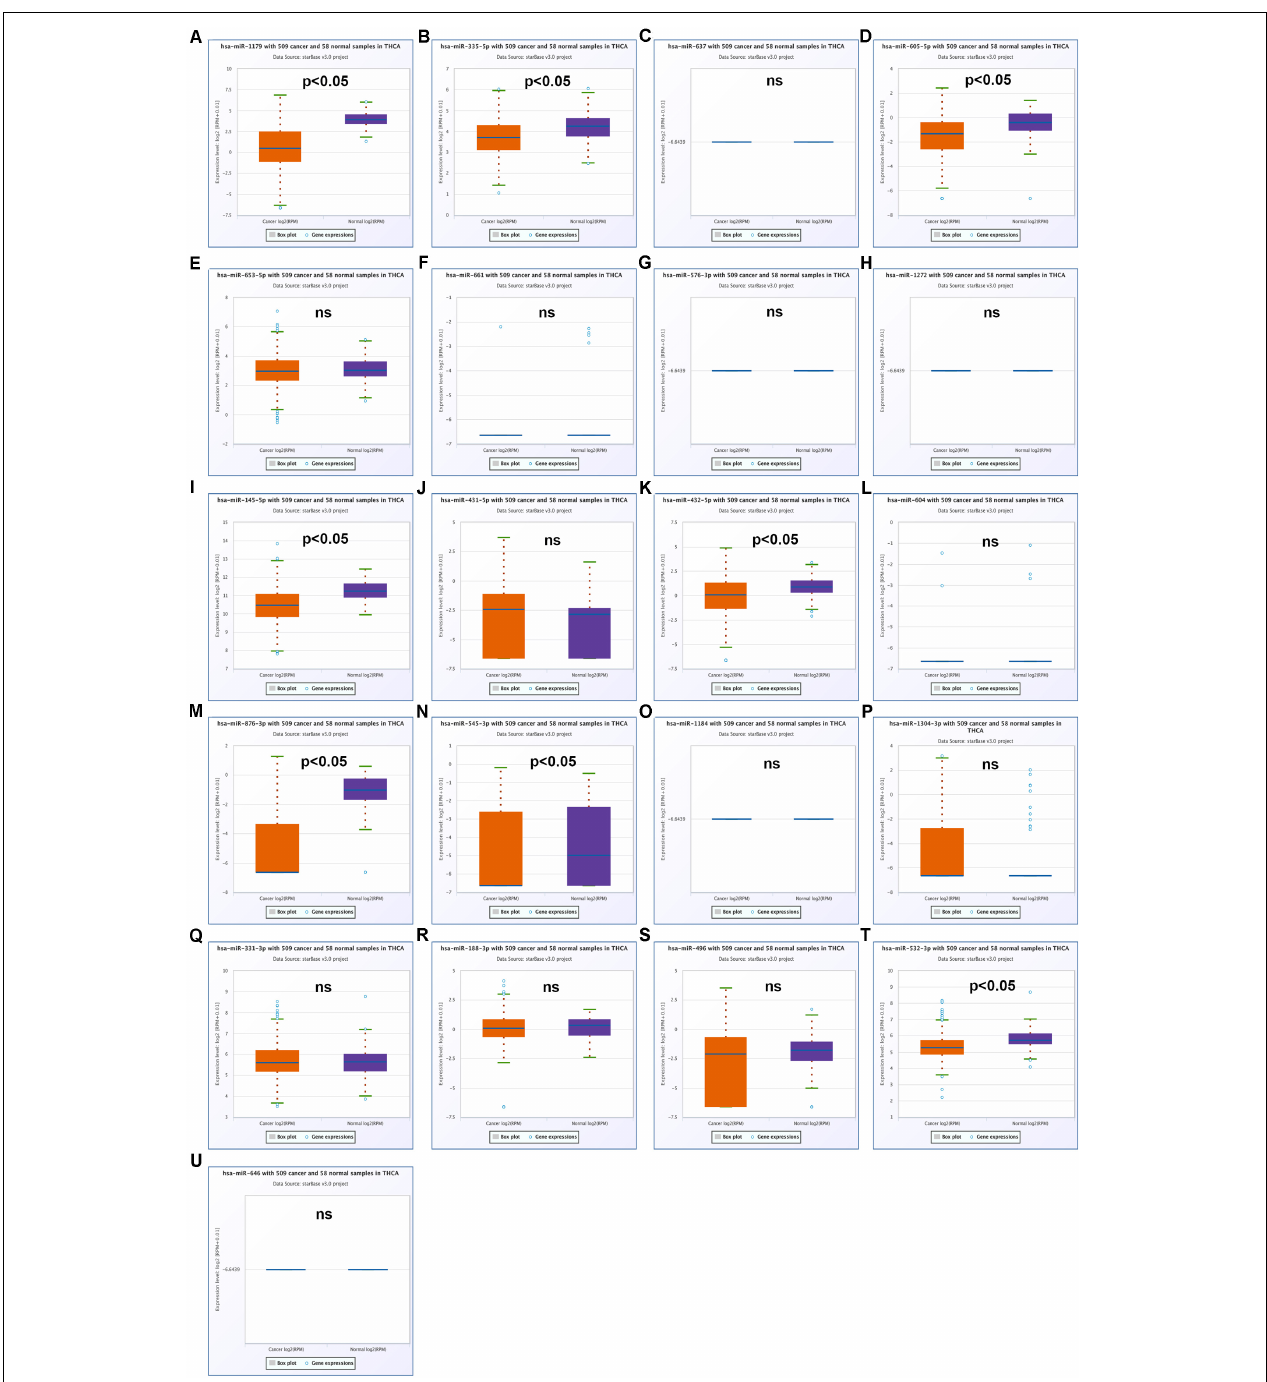
FIGURE 4 | The expression levels of 21 predicted miRNAs that potentially bind to 9 candidate circRNAs in thyroid carcinoma. (A) The expression of miR-1179 in thyroid carcinoma. (B) The expression of miR-335-5p in thyroid carcinoma. (C) The expression of miR-637 in thyroid carcinoma. (D) The expression of miR-605-5p in thyroid carcinoma. (E) The expression of miR-653-5p in thyroid carcinoma. (F) The expression of miR-661 in thyroid carcinoma. (G) The expression of miR-576-3p in thyroid carcinoma. (H) The expression of miR-1272 in thyroid carcinoma. (I) The expression of miR-145-5p in thyroid carcinoma. (J) The expression of miR-431-5p in thyroid carcinoma. (K) The expression of miR-432-5p in thyroid carcinoma. (L) The expression of miR-604 in thyroid carcinoma. (M) The expression of miR-876-3p in thyroid carcinoma. (N) The expression of miR-545-3p in thyroid carcinoma. (O) The expression of miR-1184 in thyroid carcinoma. (P) The expression of miR-1304-3p in thyroid carcinoma. (Q) The expression of miR-331-3p in thyroid carcinoma. (R) The expression of miR-188-3p in thyroid carcinoma. (S) The expression of miR-496 in thyroid carcinoma. (T) The expression of miR-532-3p in thyroid carcinoma. (U) The expression of miR-646 in thyroid carcinoma. “ p < 0.05” represents significant difference, and “ns” represents no significance.